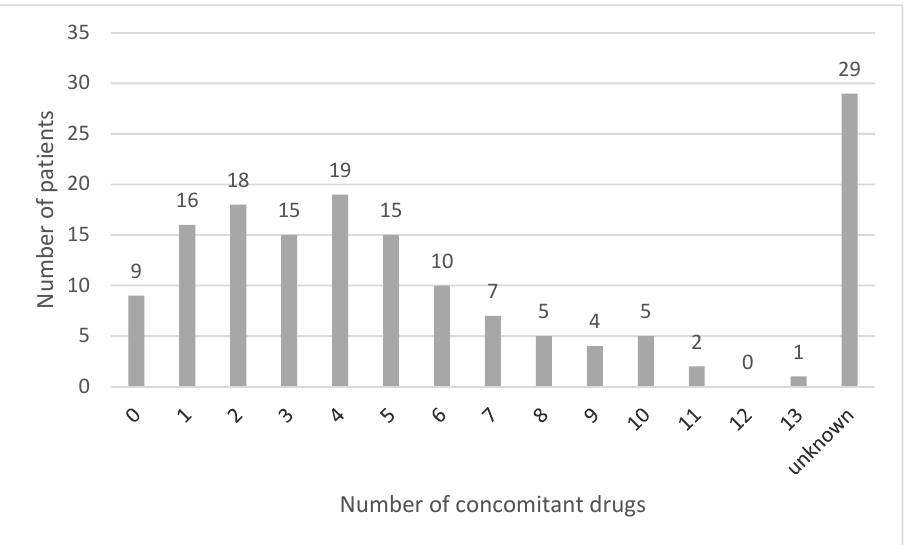
Figure 2. Description of the prevalence of polypharmacy (Note: “unknown” means that it is unknown if the patients were taking concomitant medication or not).